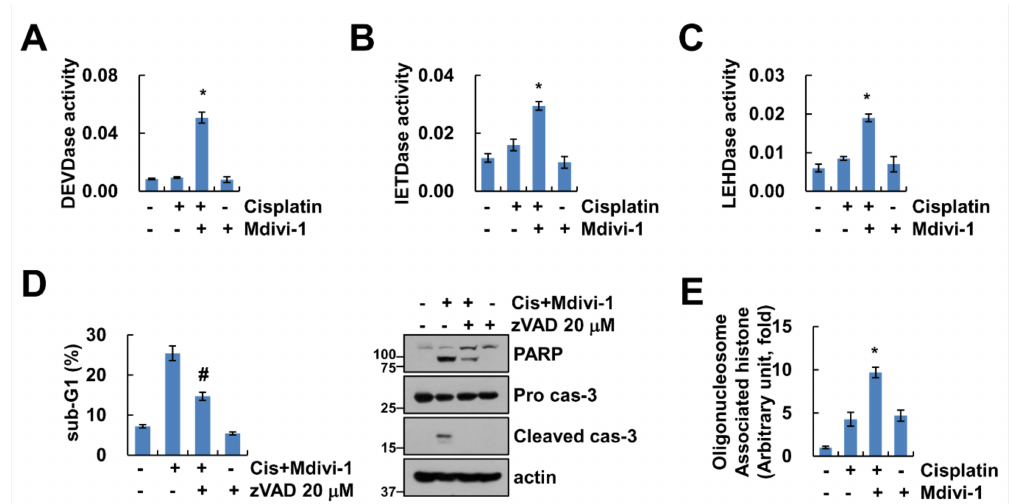
Figure 3. Combined treatment of mdivi-1 plus cisplatin induces caspase-dependent cancer cell death. ( A – C ) Caki-1 cells were treated with 10 µ M mdivi-1 alone, 20 µ M cisplatin alone, or mdivi-1 plus cisplatin for 24 h, and measured DEVDase (caspase-3, A ), IETDase (caspase-8, B ) or LEHDase (caspase-9, C ) activity. ( D ) Caki-1 cells were treated with 10 µ M mdivi-1 plus 20 µ M cisplatin in the presence or absence of 20 µ M z-VAD for 24 h. The sub-G1 population and protein expression were detected by flow cytometry and Western blotting, respectively. ( E ) Caki-1 cells were treated with 10 µ M mdivi-1 alone, 20 µ M cisplatin alone, or mdivi-1 plus cisplatin for 24 h, and detected DNA fragmentation using detection kit. The values in graph ( A – E ) represent the mean ± SEM of three independent experiments. * p < 0.01 compared to the control. # p < 0.01 compared to the mdivi-1 plus